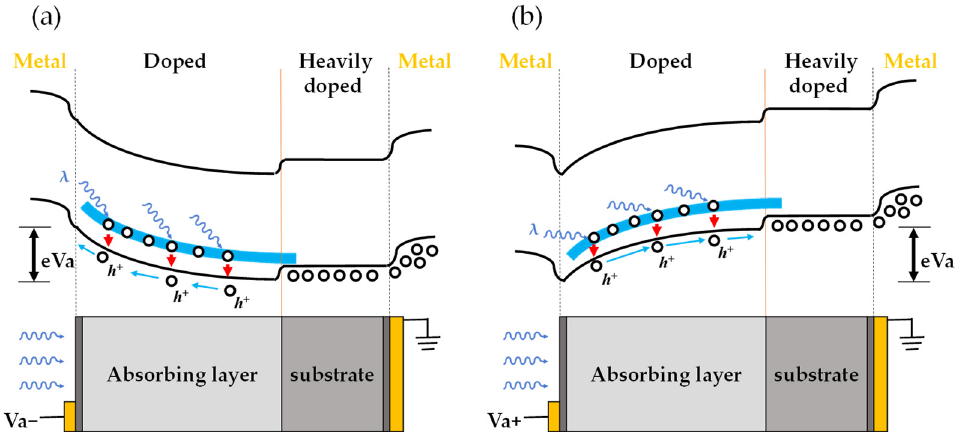
Figure 4. Schematic diagram of the energy band structure and detection mechanism of the Ge:Ga photoconductive detector under negative bias voltage ( a ) and positive bias voltage ( b ).